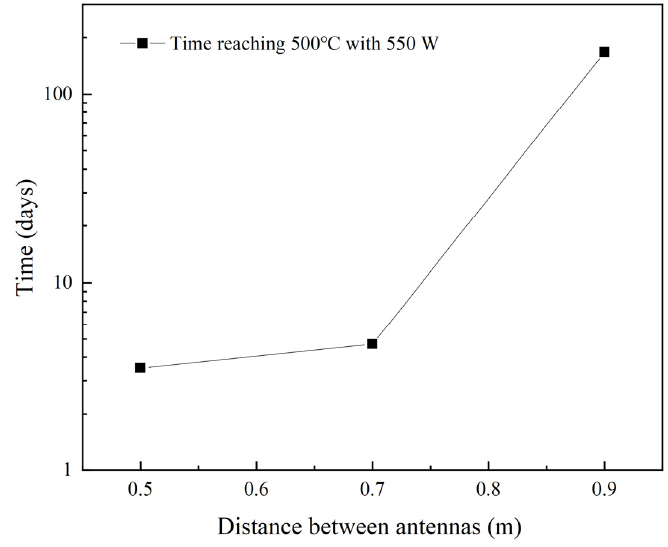
Figure 10. The effect of the distance between two antennas on time reaching 500 °C at 550 W under microwave heating.